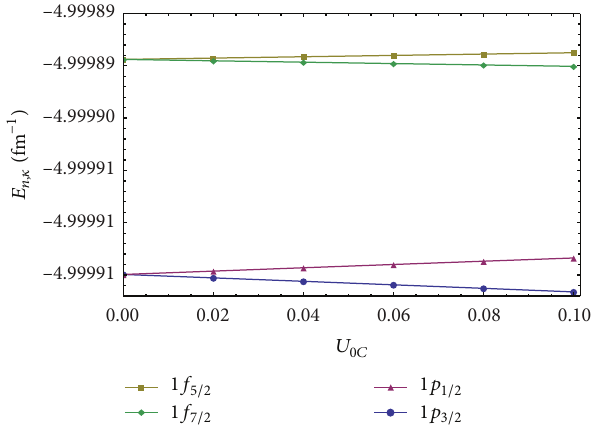
Figure 6: Contribution of the tensor Coulomb potential parameter to the energy levels in the case of spin symmetry.